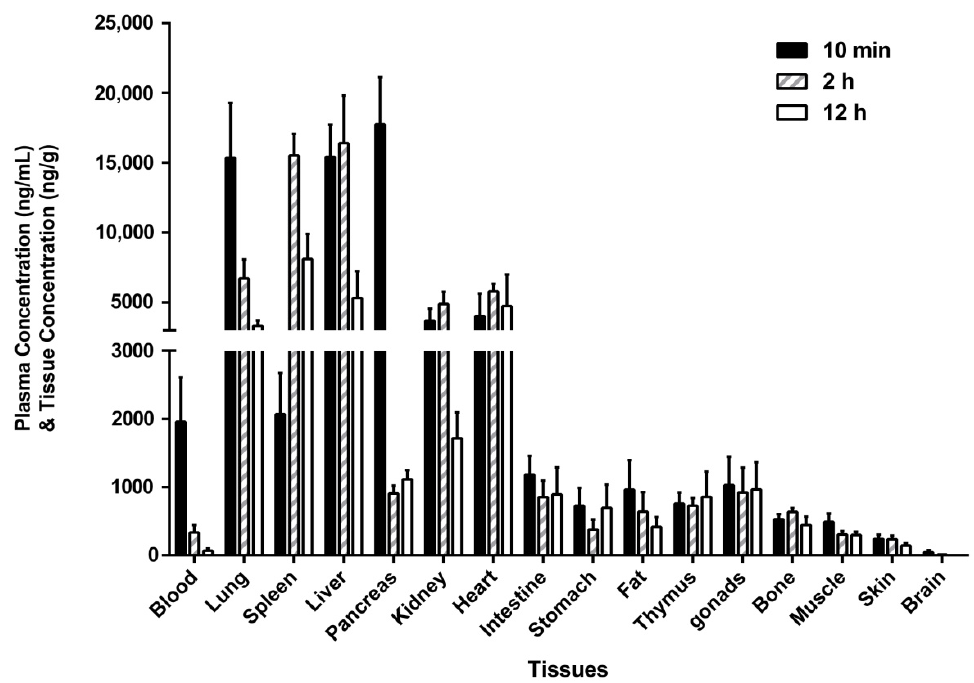
Figure 4. The distributed amount of GC20 in rat tissues at 10 min, 2 h, and 12 h after single intravenous administration of GC20 at 2 mg/kg (mean ± SD, n = 6).